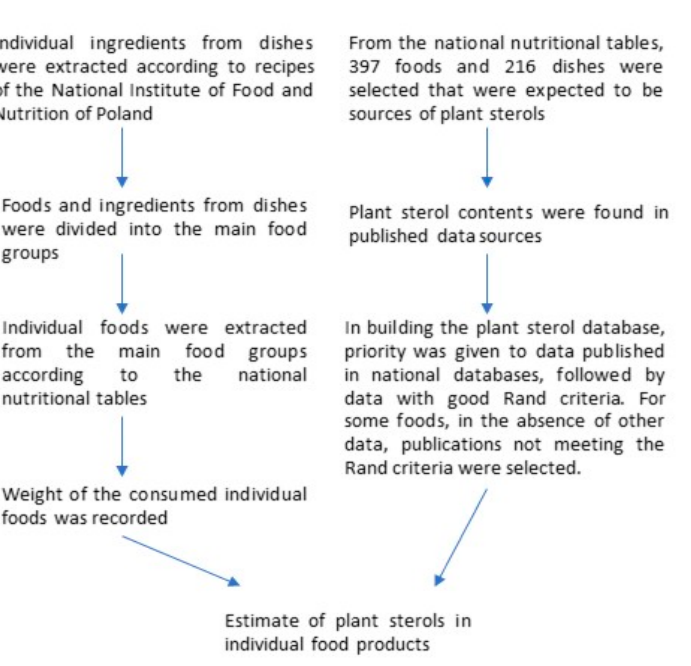
Figure 1. The process used to estimate plant sterol intake.